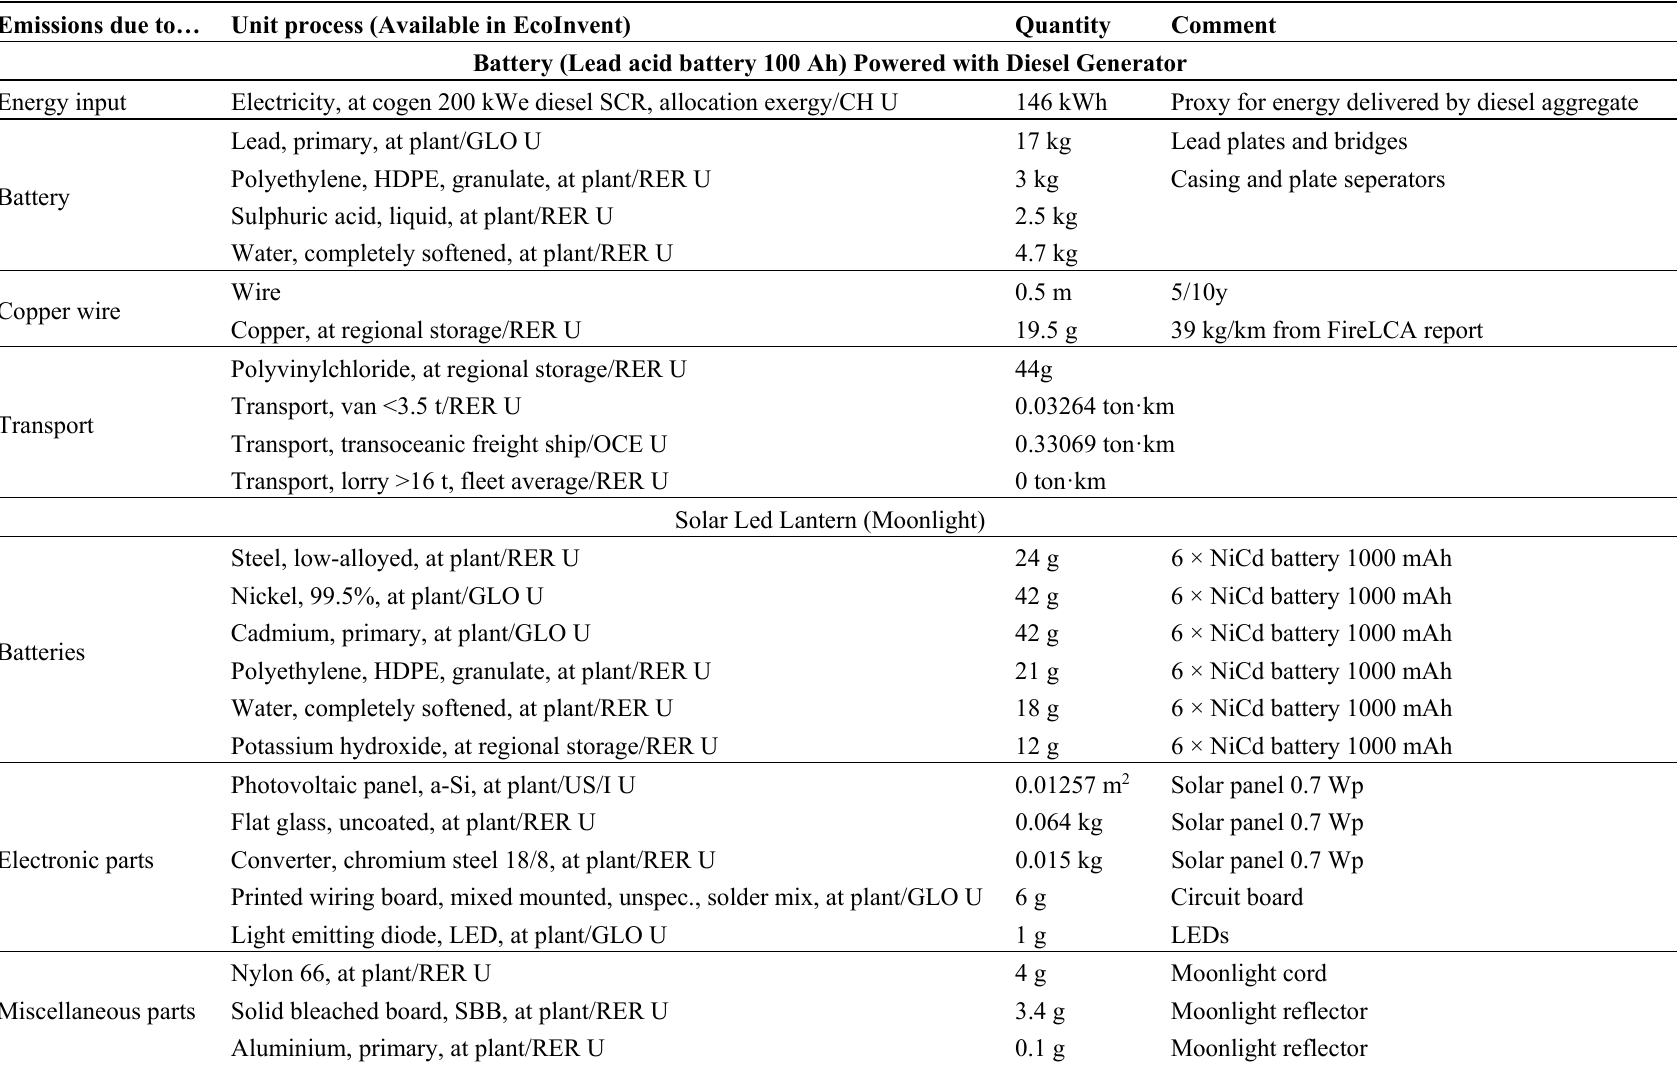
Table A2. Life cycle